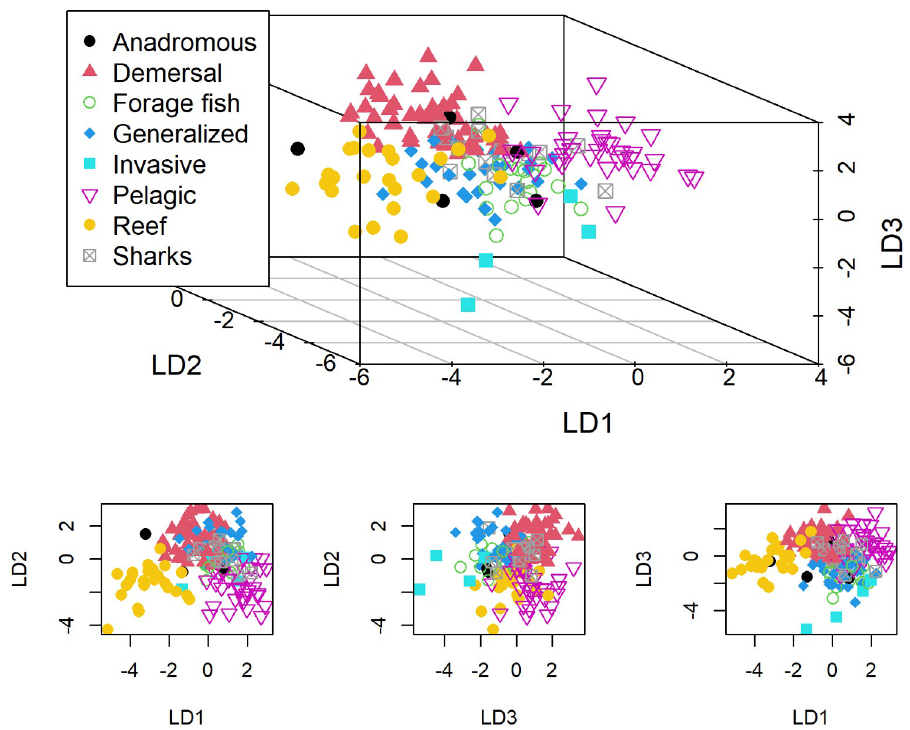
Fig 5. Linear discriminant analysis showing differences in predictor variables tested among fish guilds. The three discriminates (LD1, LD2, LD3) are multivariate combinations of predictor variables tested in 224 marine fish spatial modeling studies. Each fish guild is distinguished by color and shape as depicted in the